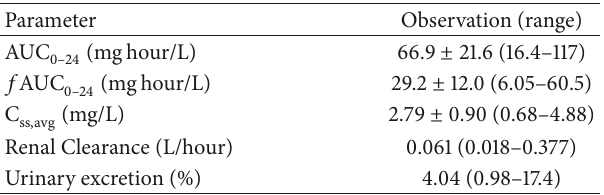
Table 2: Population pharmacokinetics of polymyxin B